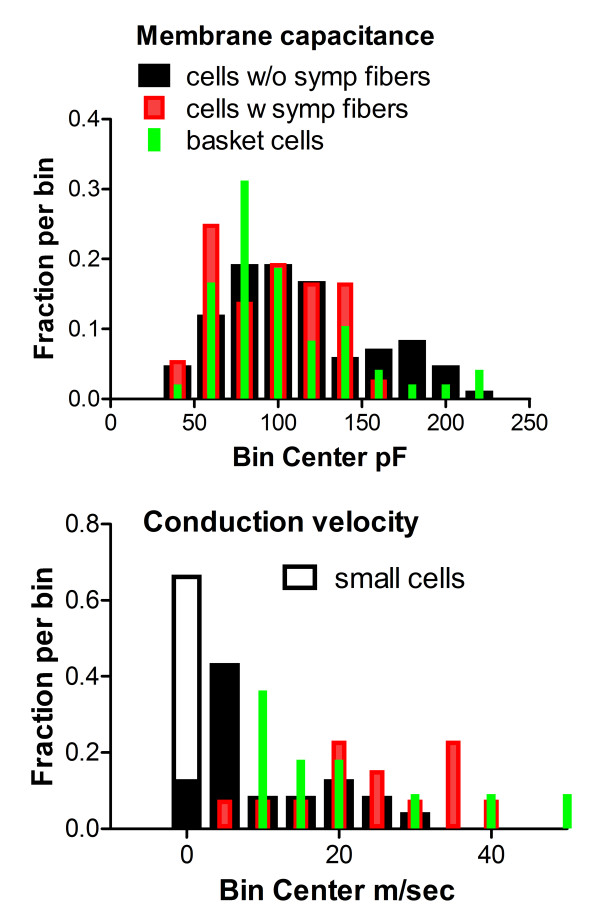
Characteristics of basket cells. Top: membrane capacitance distribution for all cells studied after identification of sympathetic fiber status. Bottom: distribution of dorsal root conduction velocities measured in a subset of the same cells. No basket cells had conduction velocities below 9.5 m/sec. For comparison, conduction velocities measured in a subset of cells, defined by our criteria as small cells and excluded from the other analyses, are also shown in the conduction velocity histogram (open bars).